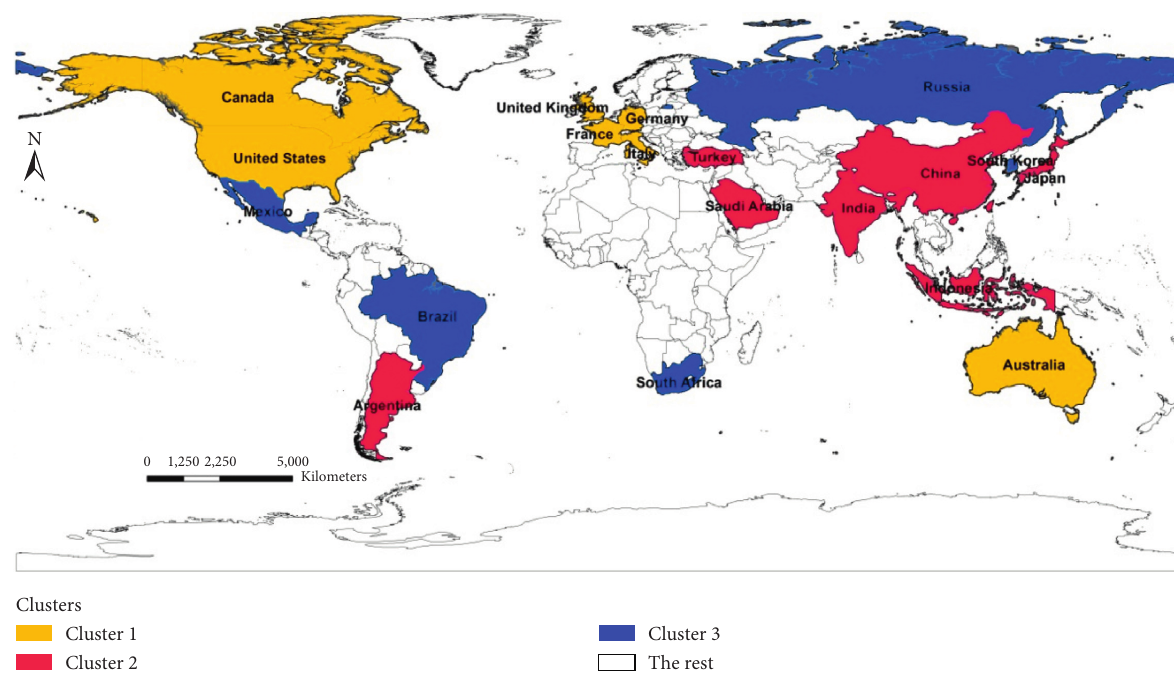
Figure 4: The clustering results of G20 stock